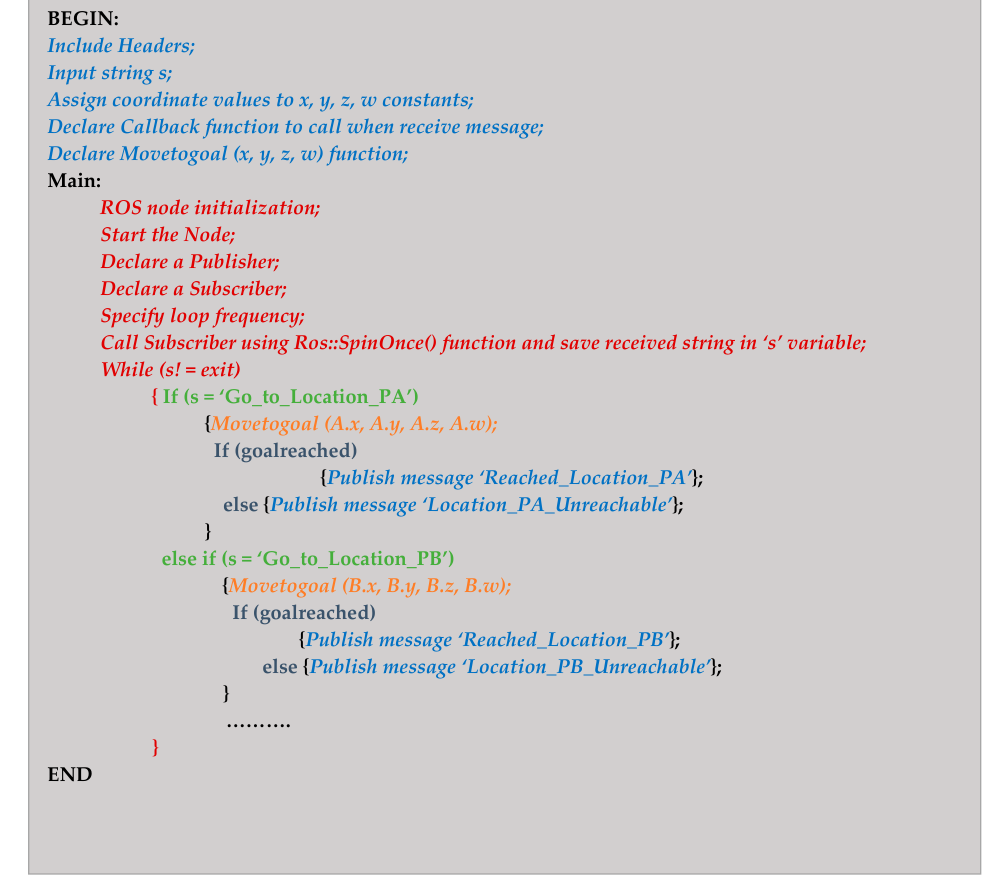
Figure 7. Pseudo ‐ code for Robot Operating System (ROS) Publisher/Subscriber node. Figure 7. Pseudo-code for Robot Operating System (ROS) Publisher / Subscriber